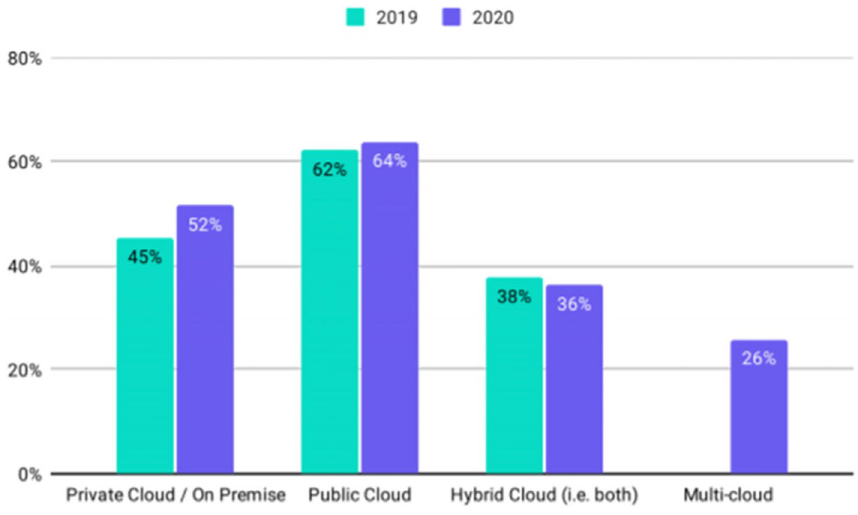
Fig. 1 CNCF survey 2020.Source: CNCF [4]